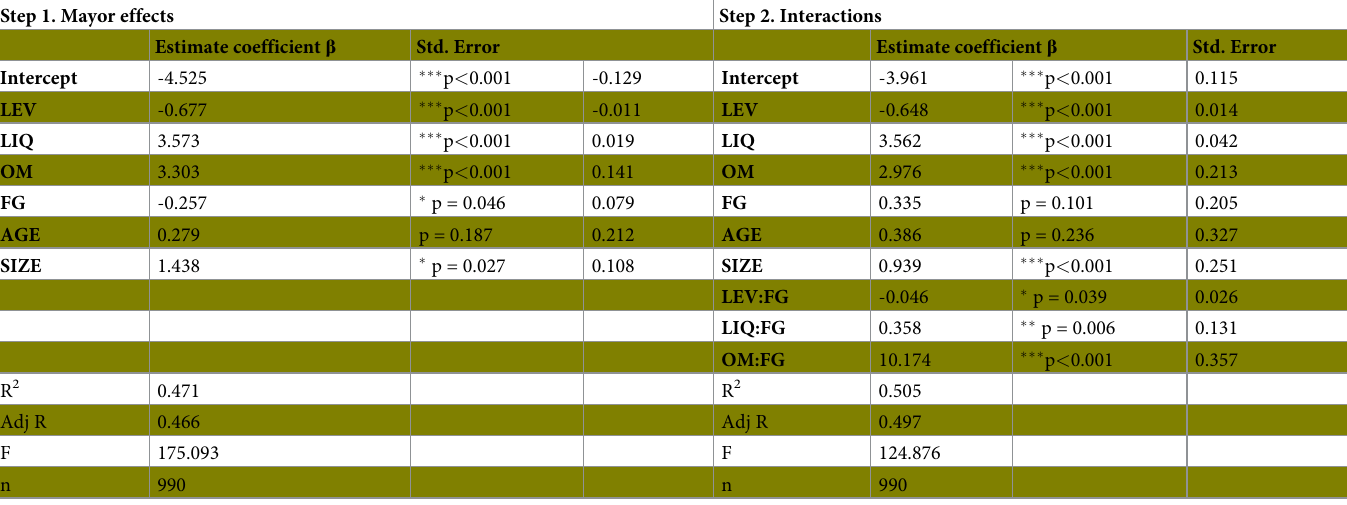
Table 4. Summary of FGLS regression